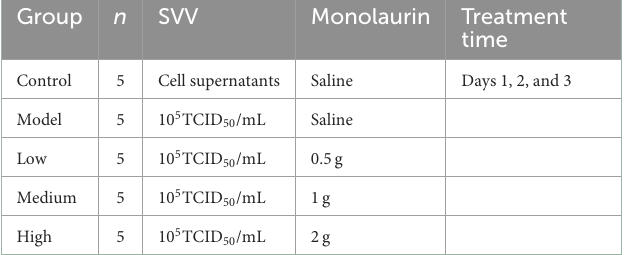
TABLE 2 The PCR master mix used for quantitative SVV detection from piglet stool and blood. Primer F: AGGTACTGGAGAAGGACGCT 0.5 µ L Primer R: GGTTGACGTACAGGCCGAAA